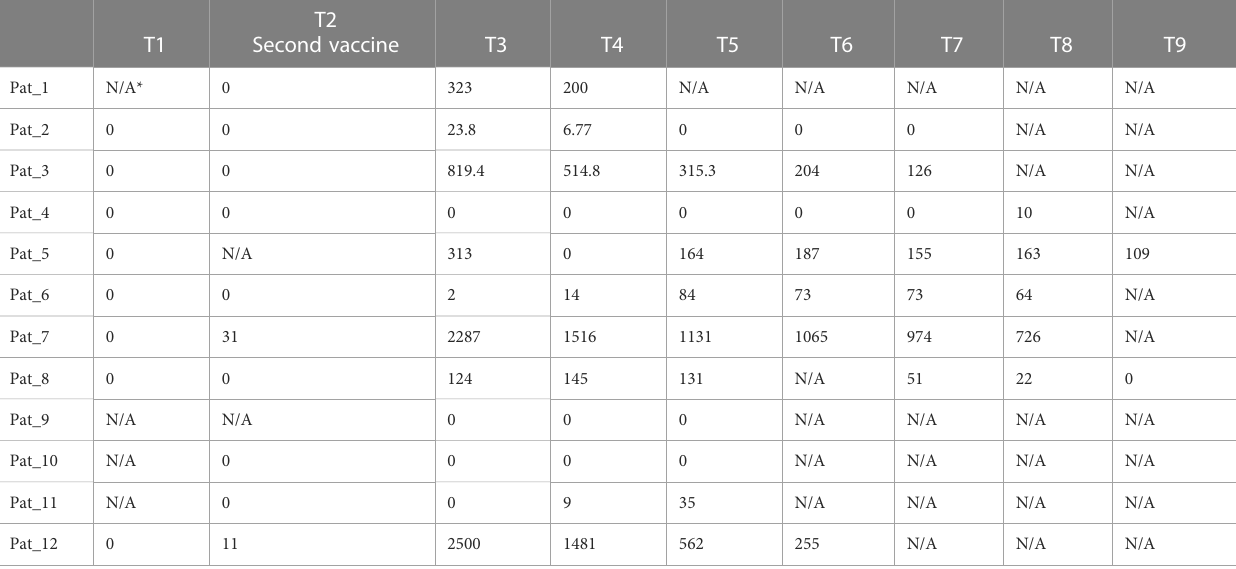
TABLE 2 Concentration (U/ml) of antibodies against SARS-CoV-2 spike antigens in cancer patients (N=12). Time points (T) between analyses range from 3 to 4 weeks.